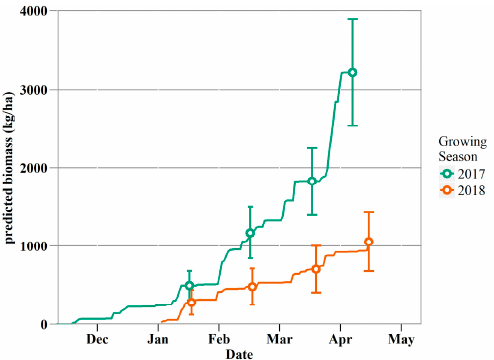
Figure 9. Daily time series of the estimated biomass averaged across the study area in 2017 and 2018 growing seasons. Error bars, denoting the standard deviation, were added to the eight sUAS flight dates, indicating the increase of spatial variability in biomass as plants grow.